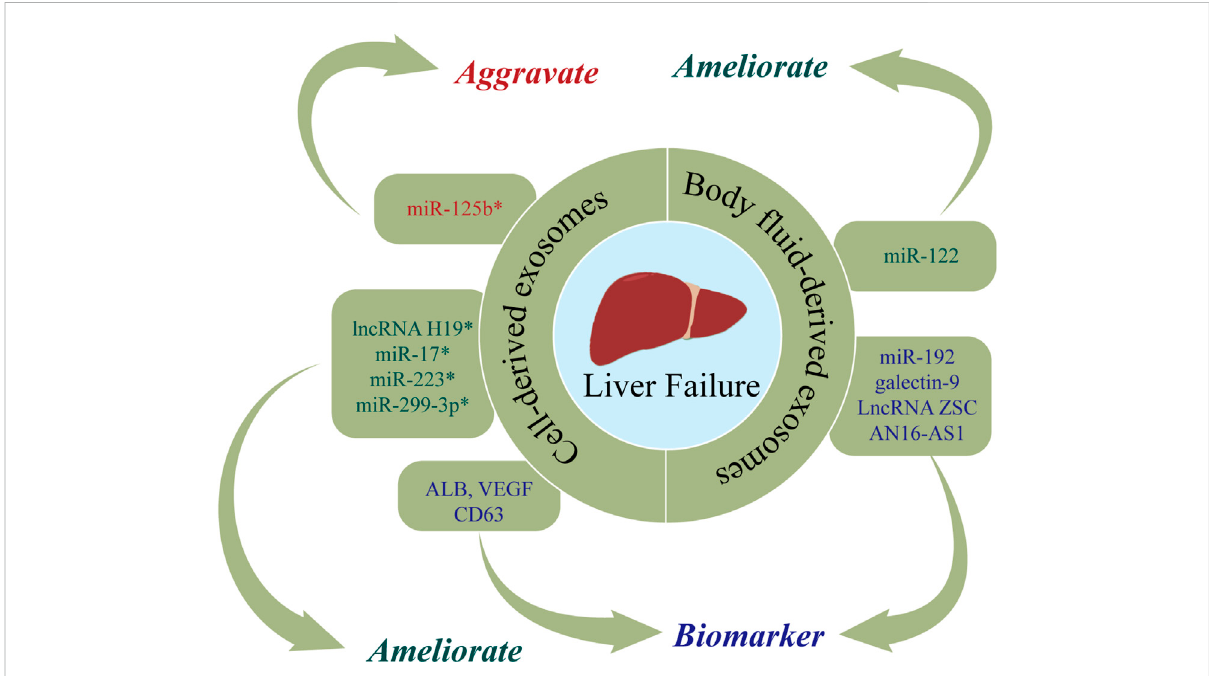
FIGURE 5 Therolesofnucleicacidsandproteinscarriedbyexosomesinliverfailure(LF).NucleicacidsorproteinsthatmayaggravateLFarehighlightedin red, ameliorating LF are highlighted in green, and biomarkers are highlighted in purple. * refers to nucleic acids and proteins carried by exosomes from mesenchymal stem